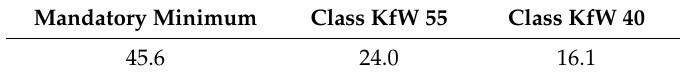
Table 4. Yearly space heating demand for different energy efficiency classes [kWh/m 2